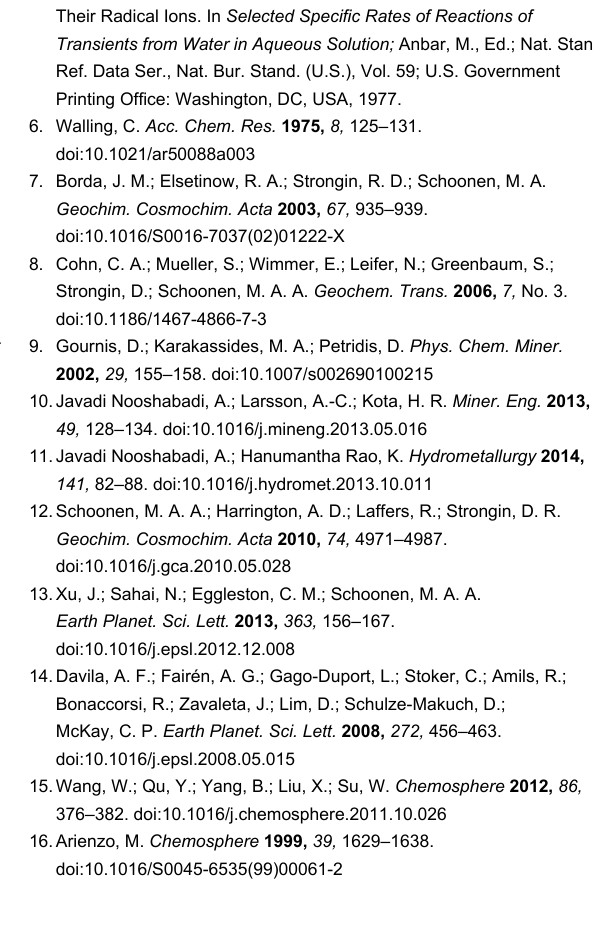
Figure 10: Experimental set-up using a liquid waveguide capillary flow cell (LWCC).